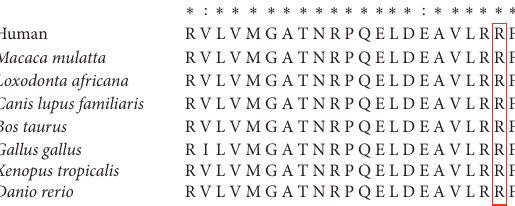
Figure 4: Sequence conservation analysis of the SPAST gene. Spastin protein sequence alignment across species showing the area of the amino acid substitution (red frame) and the surrounding